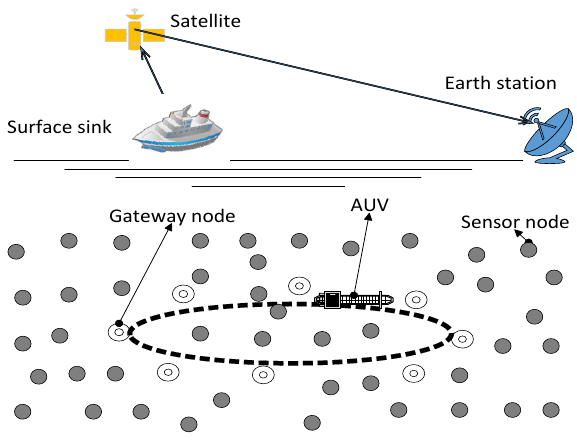
Figure 1. AUV-aided architecture of a